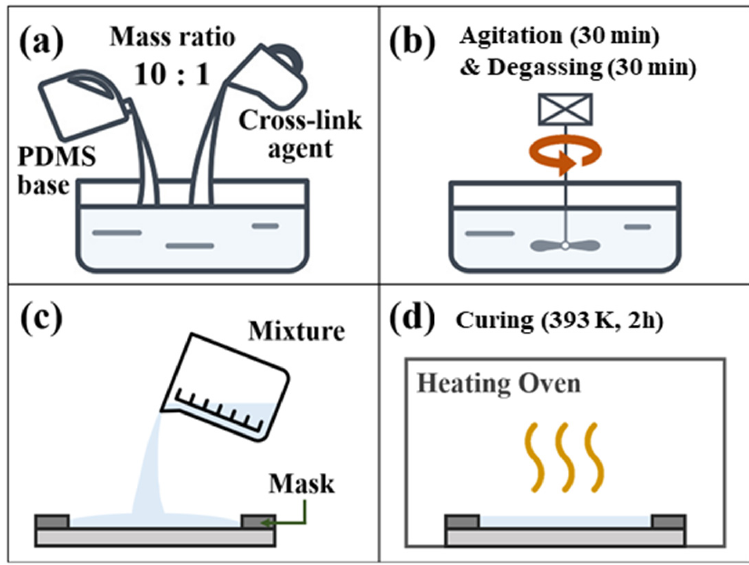
Figure 1. Schematic diagram of the manufacturing process: ( a ) PDMS mixing, ( b ) agitation & degassing process, ( c ) pouring PDMS mixture into a cavity and ( d ) curing process.